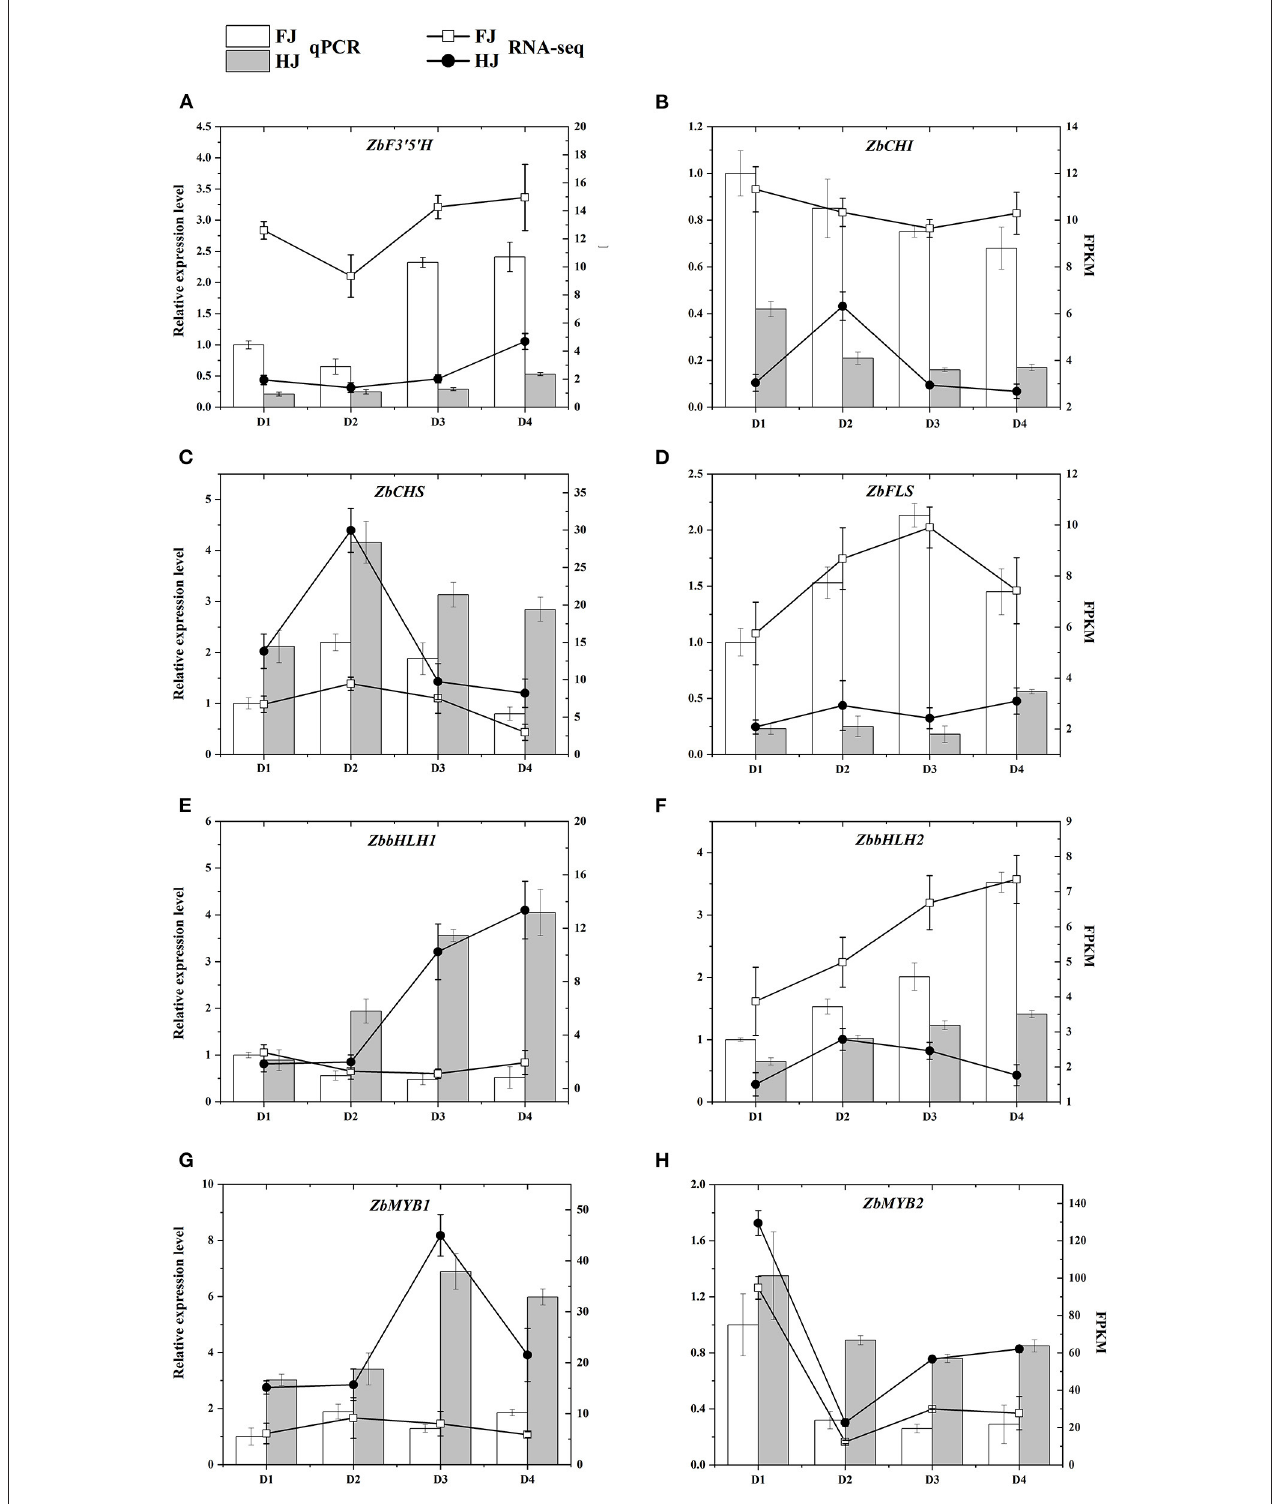
FIGURE 8 | (A–H) qRT-PCR validation of the expression patterns of candidate genes that participated in the regulation of flavonoid content in FJ and HJ leaves. The bar graphs present the results of the qRT-PCR, and the line graphs present the RNA-seq results. The scale on the left axis represents the relative expression level and the scale on the right axis represents the FPKM value. Data are means ± SD of three biological replicates.